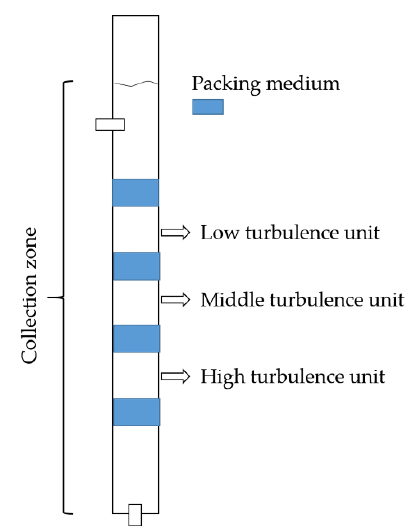
Figure 10. Schematic of hydrodynamic conditions in the collection zone of a flotation column.